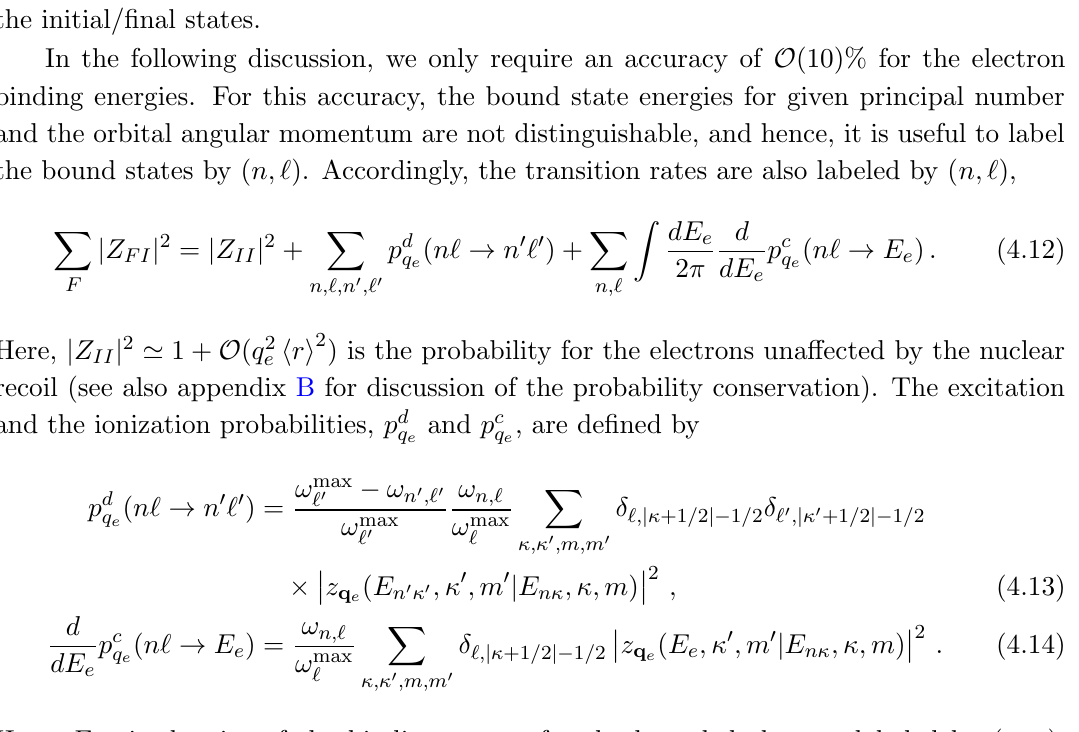
table 1), and ! max = 2(2 ‘ + 1). The (cid:12)nal state orbital angular momentum, i.e. ‘ 0 = ‘ (cid:6) 1, ‘ is summed implicitly in eq. (4.14).